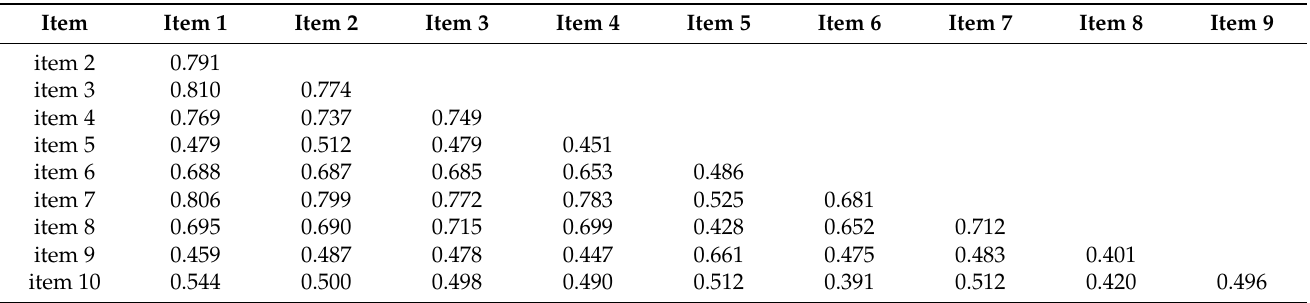
Table 2. Bivariate correlations of PL-aVHS items.